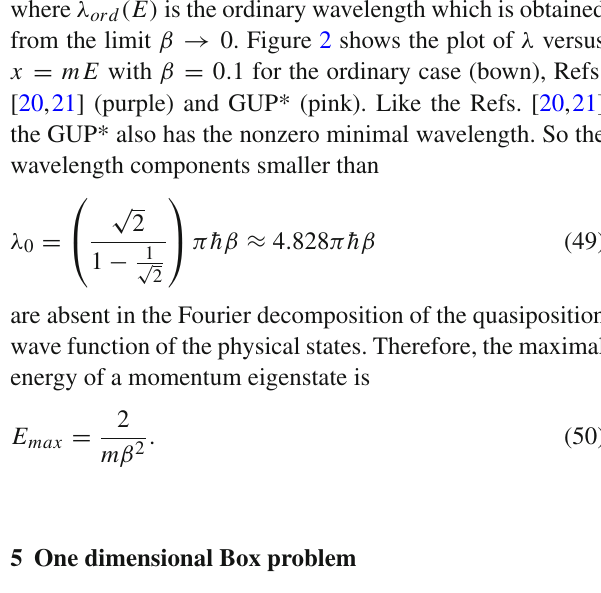
where λ ord ( E ) is the ordinary wavelength which is obtained from the limit β → 0. Figure 2 shows the plot of λ versus x = mE with β = 0 . 1 for the ordinary case (bown), Refs. [20,21] (purple) and GUP* (pink). Like the Refs.